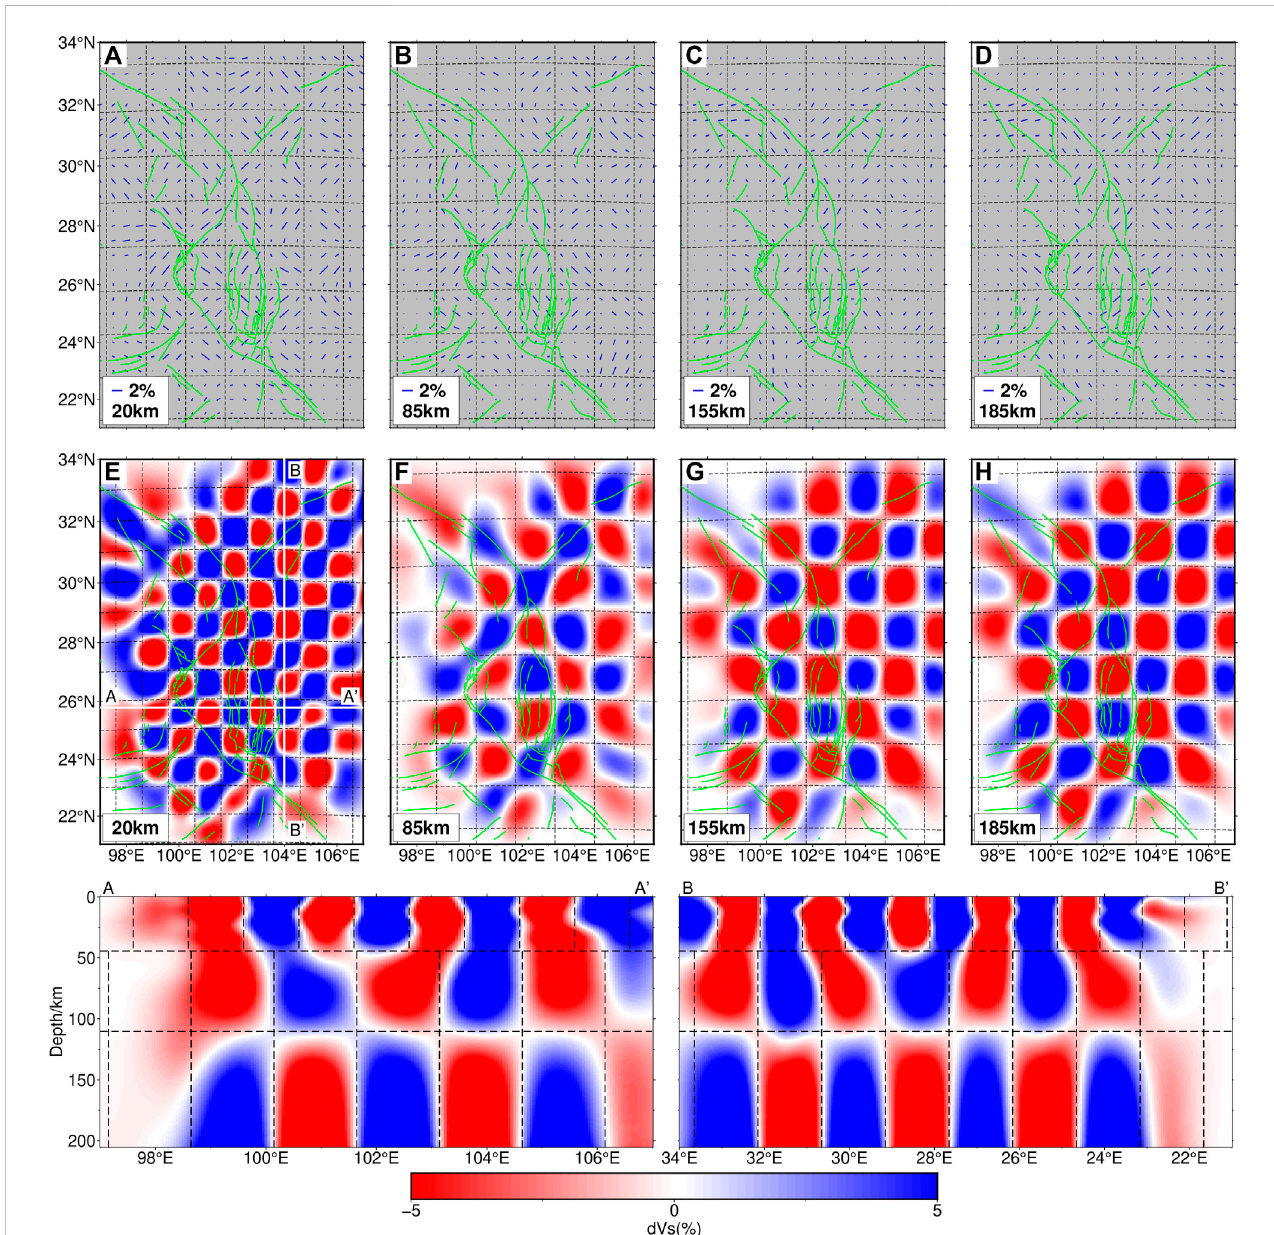
FIGURE 3 Results of checkerboard tests. The true isotropic and anisotropic anomalies are ±5% and ±2%, respectively. Figures (A – H) show the recovered anisotropicandisotropicresults,respectively.Blueshortlinesshowthefastaxisdirectionandmagnitudeofazimuthalanisotropy.Blackdashedlinesmarkthe boundaryoftrueanisotropicandisotropiccheckerboardpatterns.Greenlinesrepresentthefaults.Pro fi lesAA ’ andBB ’ showtheverticalsliceoftherecovered isotropic models, and their locations are marked as white lines in (E)